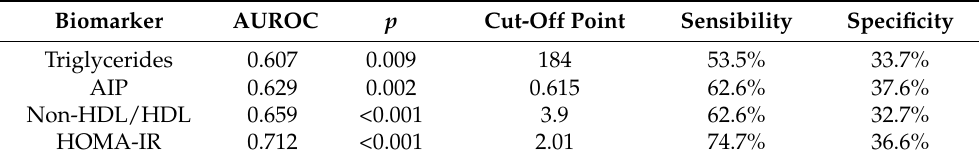
Table 5. AUROC and cut-off values of the biomarkers that were found to be independent predictors of MAFLD in patients with